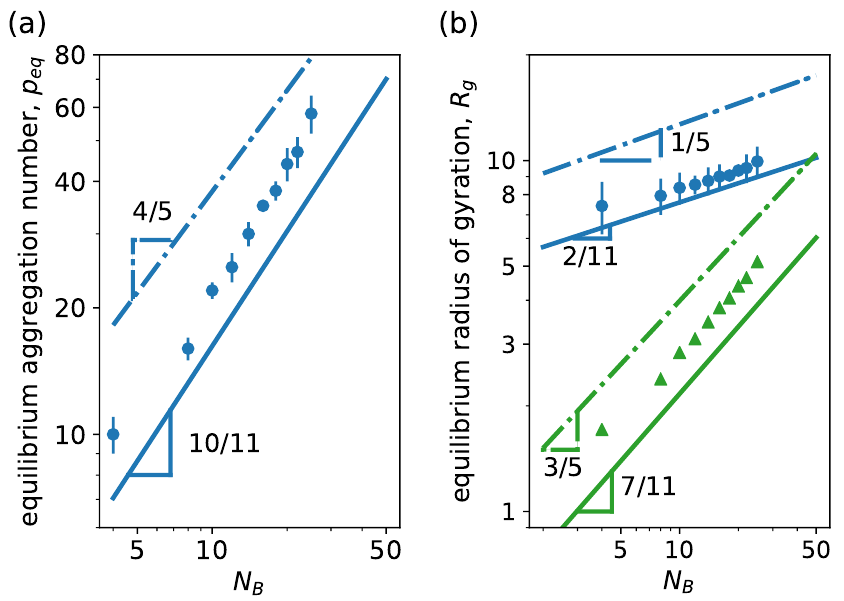
Figure 6. ( a ) Equilibrium aggregation number and ( b ) equilibrium radius of gyration versus degree of polymerization of the hydrophobic block N B . We consider linear neutral block copolymers with N A = 30. Continuous lines correspond to power law behavior predictions from mean-field theory [42], and dash-dotted lines correspond to predictions from scaling theory [59]. In ( b ), circles and triangles are results for micelle and core radii of gyration, respectively, from simulations, while blue and green lines correspond to corona and core size scaling predictions from theory. Other system parameters: w c = 1.8, (cid:101) attr = 1.0 and k B T =